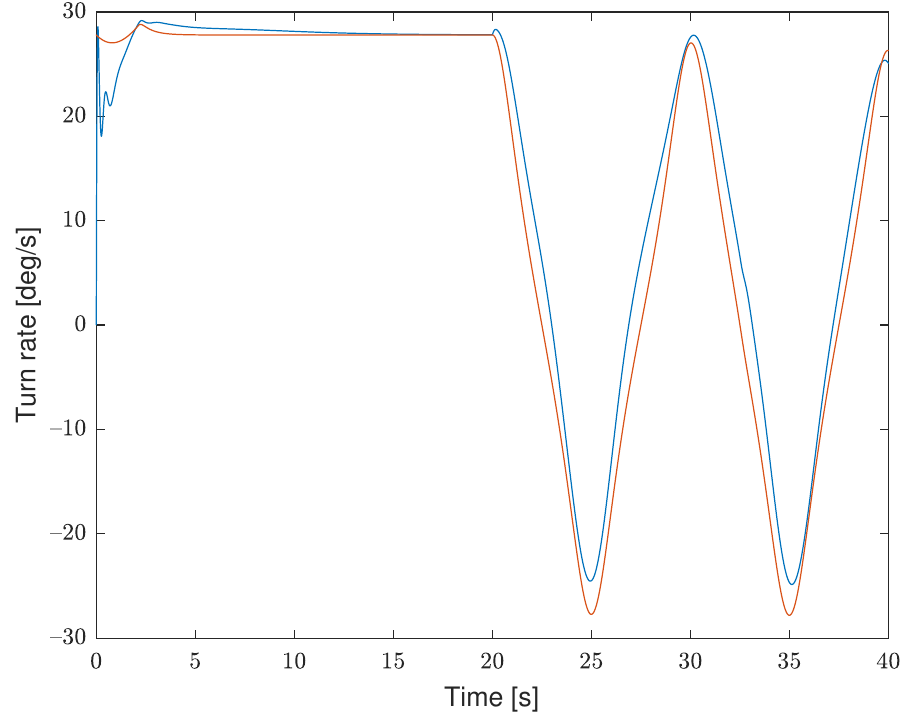
(cid:107) (blue), both parallel to η . d